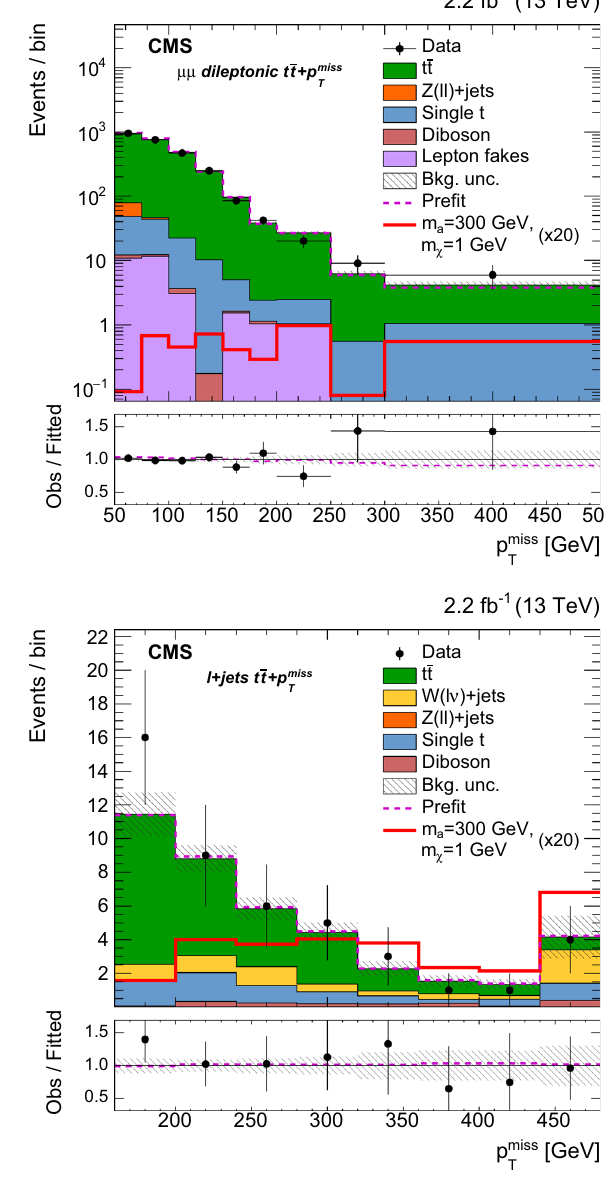
Fig. 9 The p miss distributions in the following signal regions: dilep- of an example signal (pseudoscalar mediator, m a = 300 GeV and T m χ = 1 GeV) is scaled up by a factor of 20. The last bin contains over- tonic tt + p miss in the ee signal region (upper left), in the μμ region T flow events. The lower panels of each plot show the ratio of observed (upper right), in the e μ region (lower left), and in (cid:5) + jets tt + p miss T data to fitted background. The uncertainty bands shown in these panels region (lower right). The p miss distributions of background correspond T are the fitted values, and the magenta lines correspond to the ratio of to background-only fits to the individual tt + p miss signal regions and T prefit to fitted background expectations associated background control regions. The prefit p miss distribution T